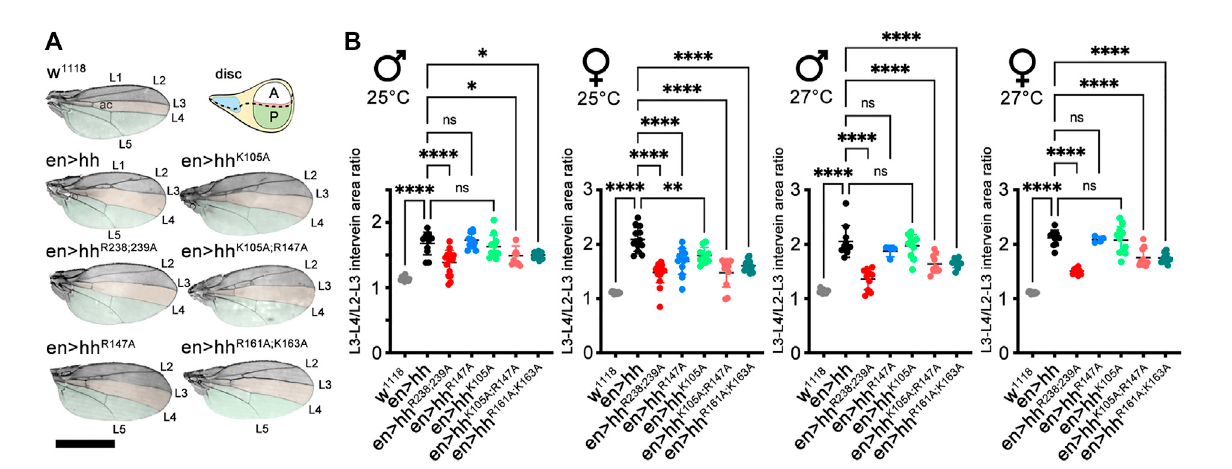
FIGURE 4 Hh and Hh variants expressed in the posterior wing disc compartment induce variable patterning of anterior wing structures. (A) Adult wings and schematic of a Drosophila third-instar wing disc. The posterior en-expression domain in the disc, and adult wing tissue arising from the posterior compartment are labeled in green. The anterior (A)/posterior (P) compartment border in the schematic is shown as a dashed line. Adult wings are shown withanteriorupandproximalleft.LongitudinalveinsL1-L5andtheanteriorcrossvein(ac)aremarked.Hhoverexpressionunderen-control(en > hh) expands the anterior L3-L4 intervein region (orange) and apposes veins L2 and L3. (B) To quantify Hh activity at two different temperatures during development, the most proximal L3-L4 areas highlighted in orange were determined and the values divided by the L2-L3 areas. One-way ANOVA, two- tailed, Dunnett ’ s multiple comparisons post hoc test. **** p ≤ 0.0001, *** p ≤ 0.001, ** p ≤ 0.005, * p ≤ 0.01. Also see Supplementary Table S2 for exact statistical results. Scale bar: 1